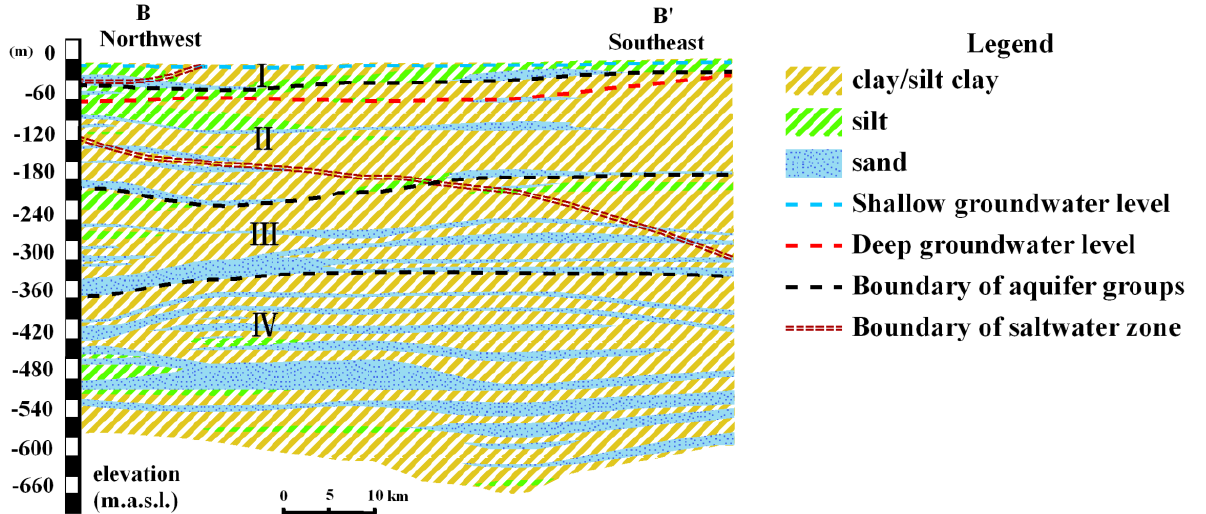
Figure 3. Lithology and aquifer division of transect B–B' in Cangzhou (modified from Zhang et al.